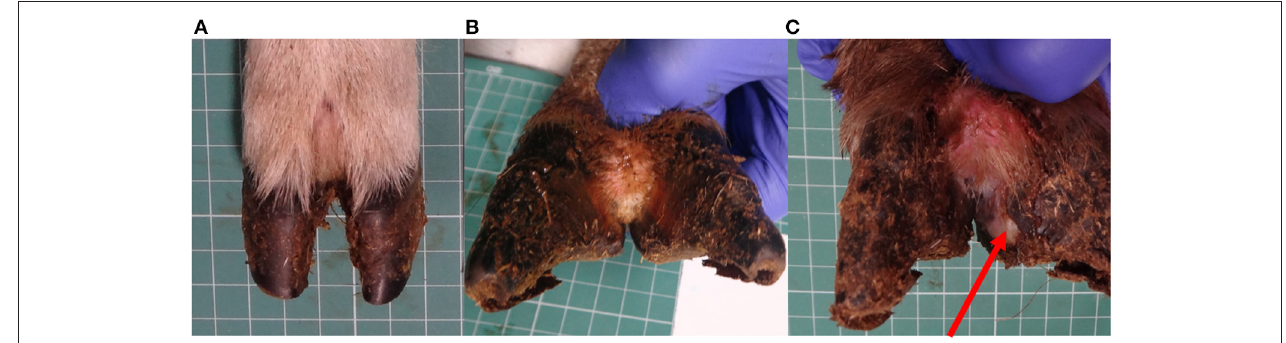
FIGURE 2 | Healthy sheep’s foot (A) , ID lesion (B) , and FR lesion (C) , arrow pointing to under run horn tissue.